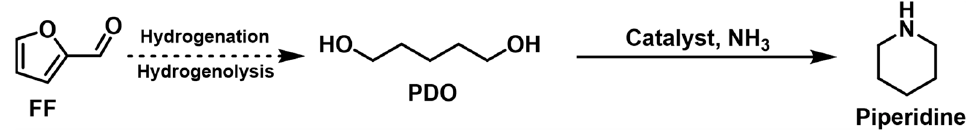
Figure 11. Hydrogen-borrowing amination of PDO and NH 3 to synthesize piperidine.